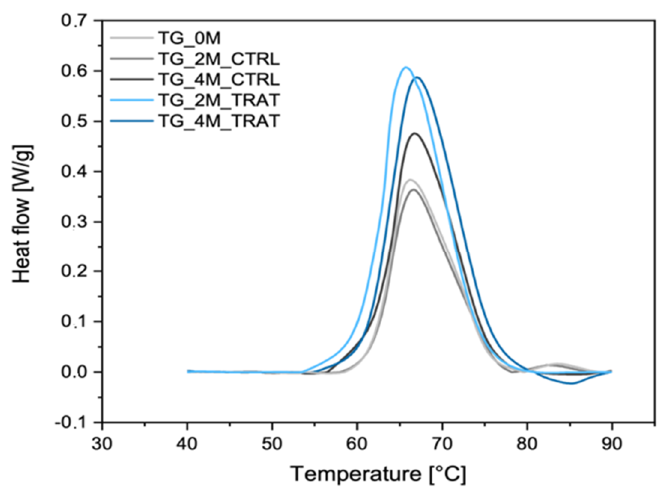
Figure 6. Representative thermograms of Tilapia skin from fish fed with conventional feed at time point 0 (TG_0M, light grey), two (TG_2M_CTRL, grey), and four months (TG_4M_CTRL, dark grey) and from fish fed a collagen-supplemented diet at two (TG_2M_TRAT, light blue) and four months (TG_4M_TRAT, blue). Table 2. Mean values of the endothermic peak (Td) and enthalpy (ΔH) required for the endothermal transition that occurred on skin samples ( n = 9, mean ± SD).